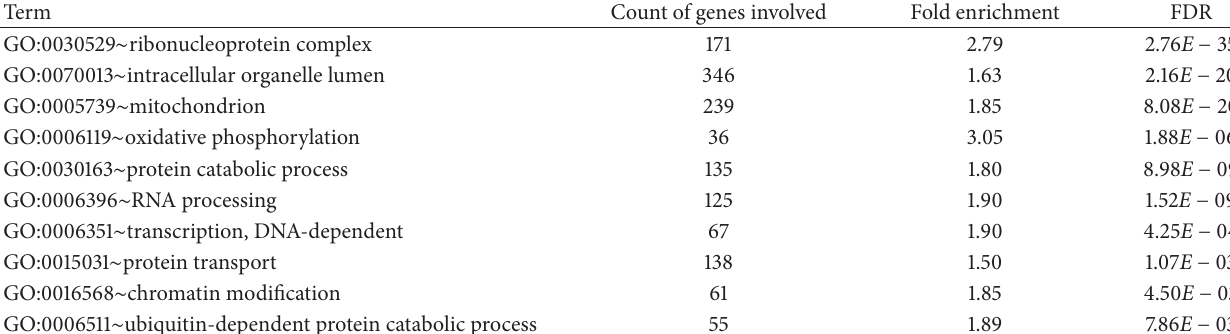
Table 4: Representative DAVID results of pathway that was differentially expressed between COPD and control groups.